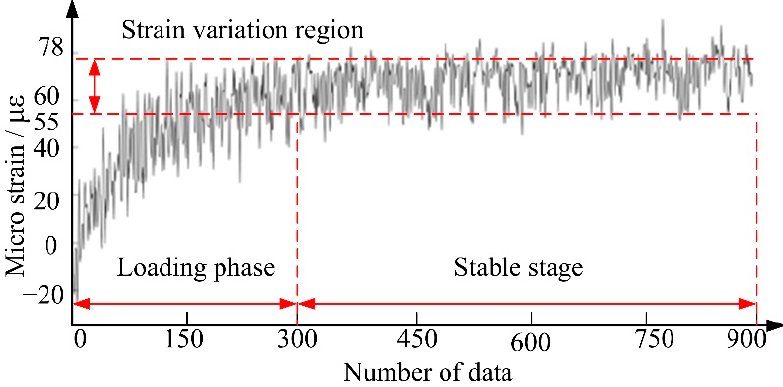
Figure 13. Strain curve of rolling element entering variable diameter raceway.